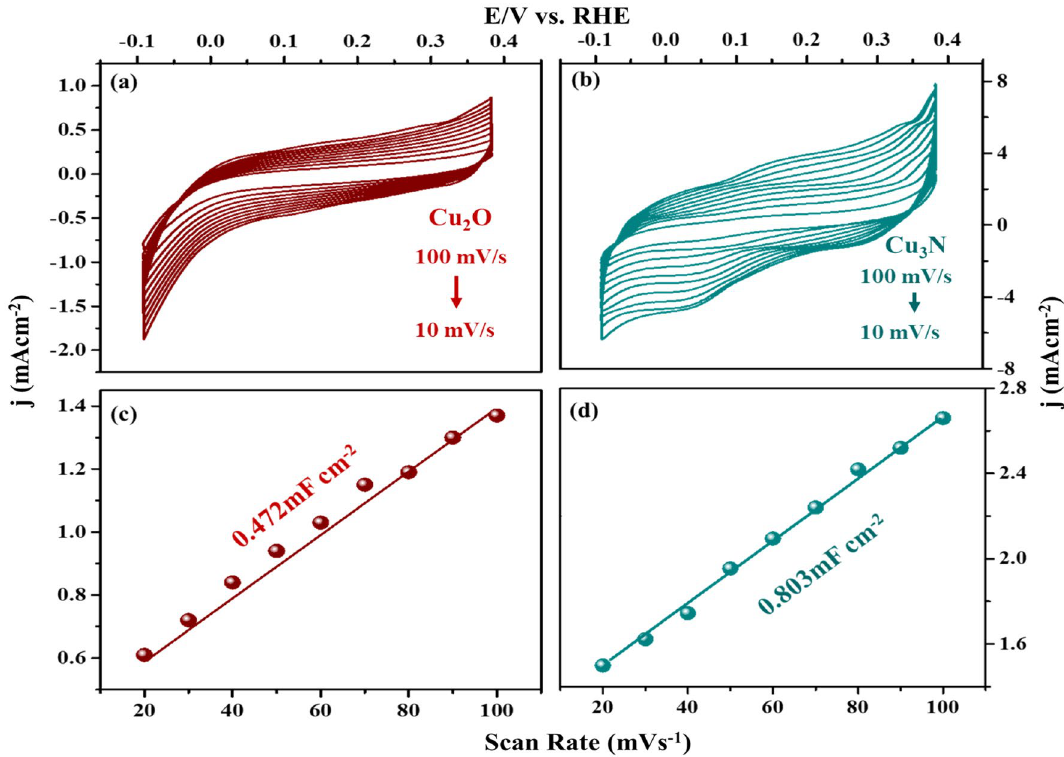
Figure 11. Cyclic voltametric analysis at various scan rates from − 0.1 to 0.4 V vs. Ag/AgCl ( a ) Cu 2 O, ( b ) Cu 3 N. Cdl calculations of ( c )